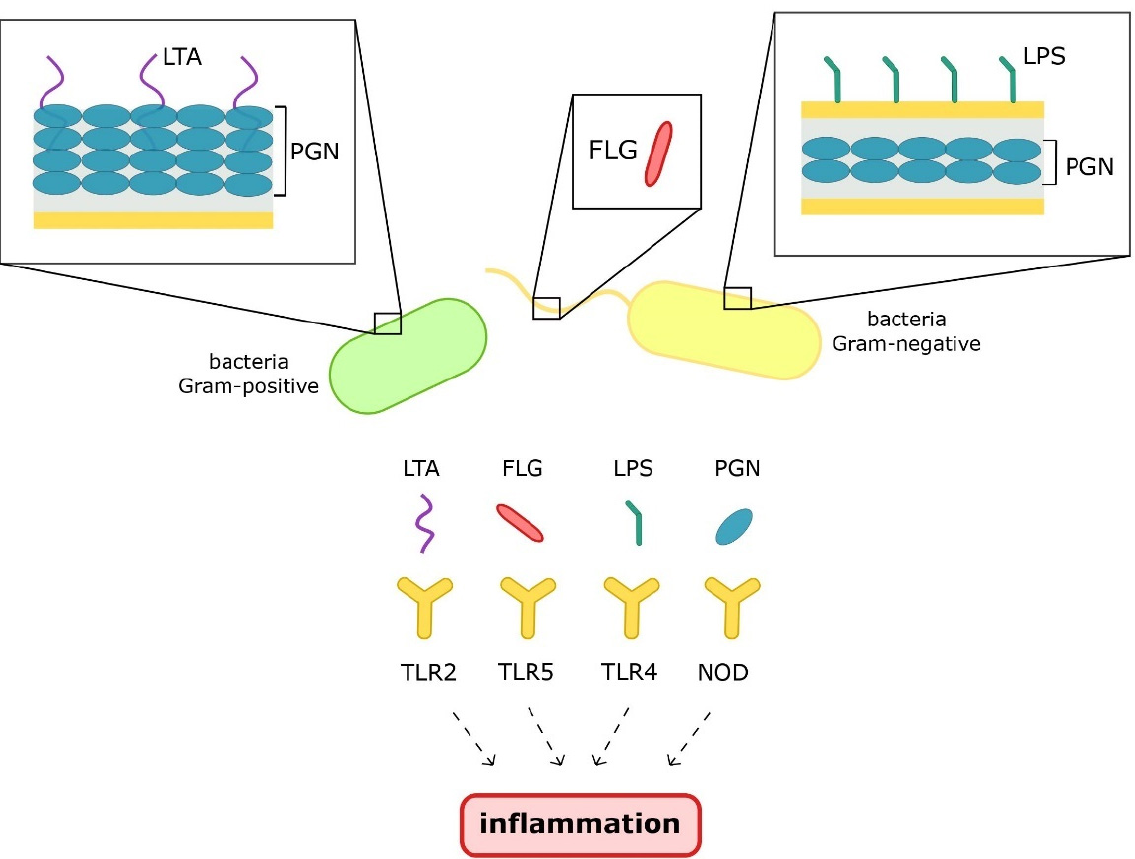
Figure 2. Origin and receptors of pathogen-associated molecular patterns. Aberrations: LTA—lipoteichoic acid; PGN—peptidoglykan; FLG—flagellin; LPS—lipopolisaccharide; TLR2/4/5 –toll-like receptors2/4/5; NOD—nucleotide-binding oligomerization domain.